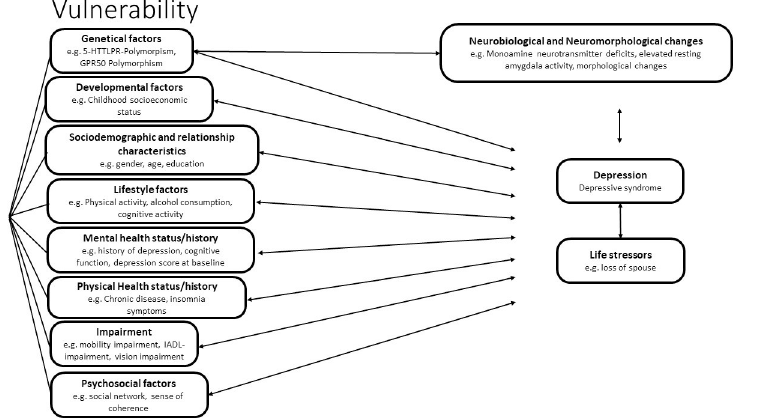
Fig 1. Conceptual framework of risk factors for incident